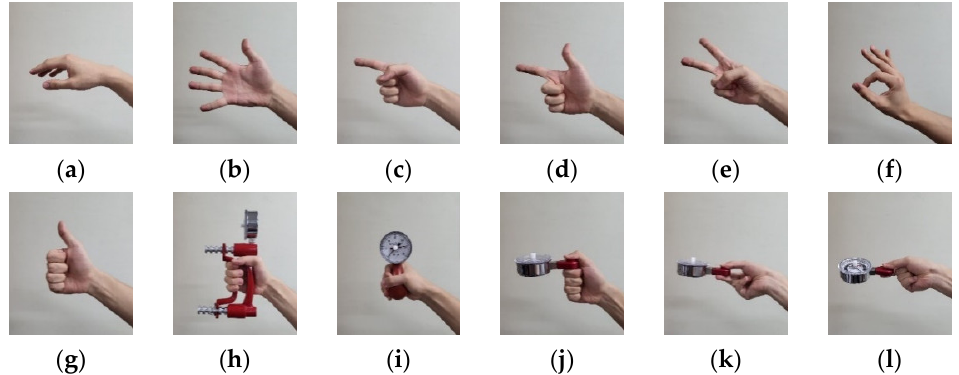
Figure 4. Hand postures for the sEMG-based posture recognition: ( a ) rest, ( b ) spread, ( c ) finger pointing, ( d ) scissor sign, ( e ) V sign, ( f ) O.K. sign, ( g ) thumb up (hook), ( h ) cylindrical grasp, ( i ) spherical grasp, ( j ) lateral pinch, ( k ) palmar pinch, ( l ) tip pinch.